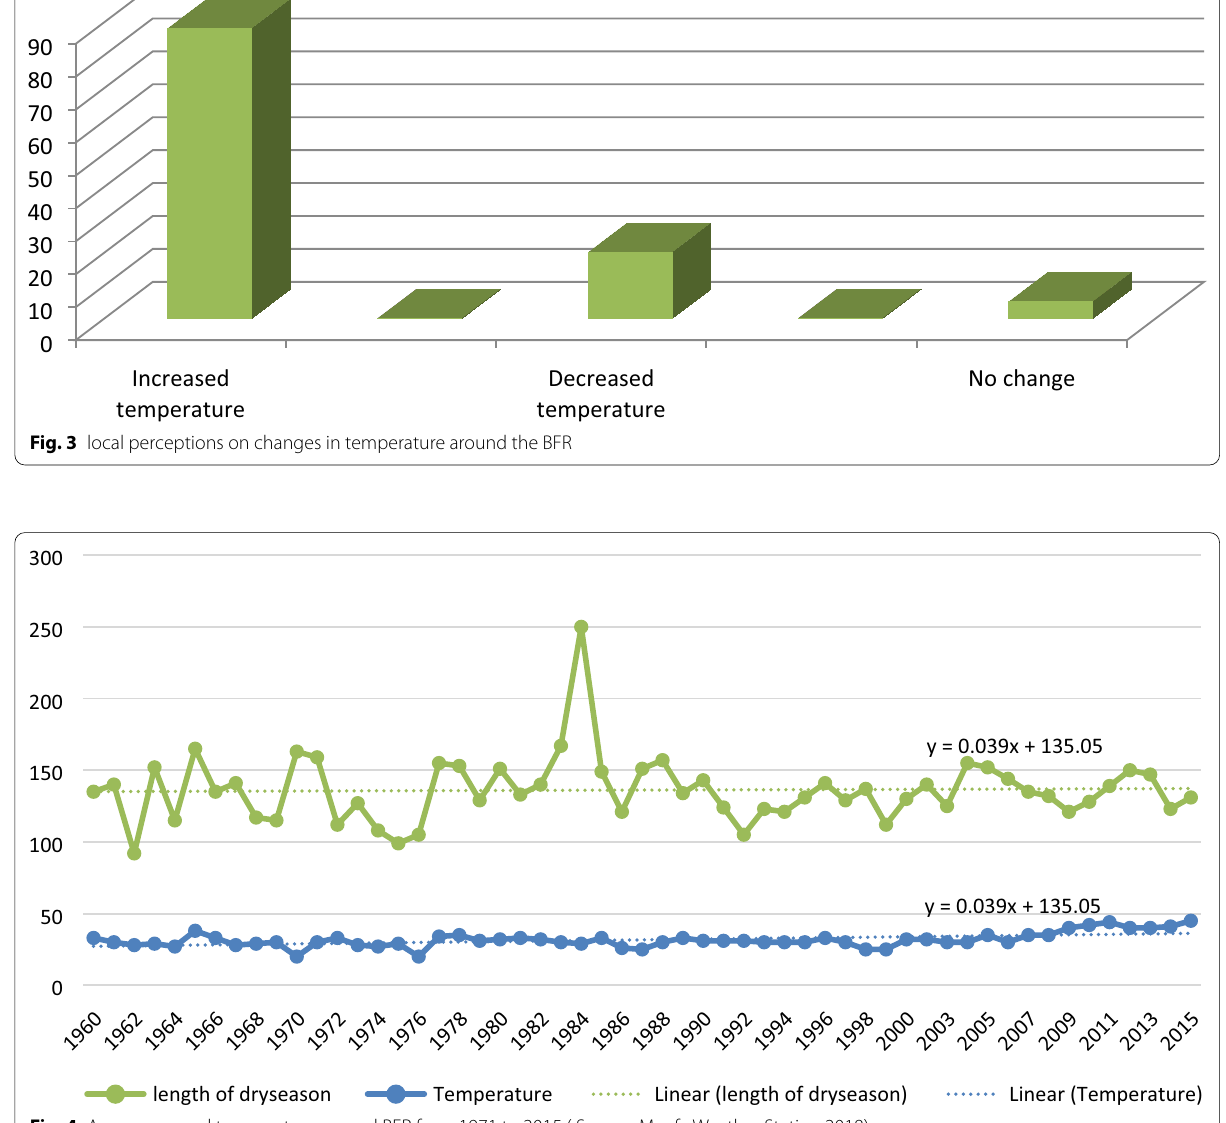
Fig. 4 Average annual temperature around BFR from 1971 to 2015 ( Source: Manfe Weather Station